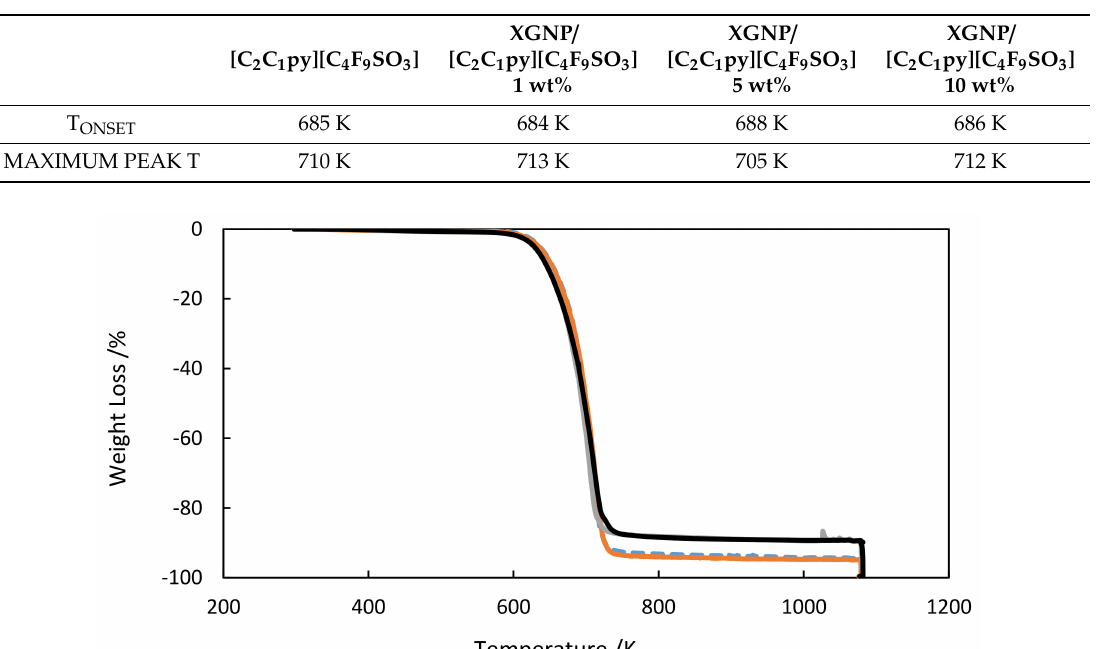
Table 1. Onset temperatures and maximum peaks of xGnP / [C 2 C 1 py][C 4 F 9 SO 3 ] obtained with temperature variation rates of 5 K · min − 1 .